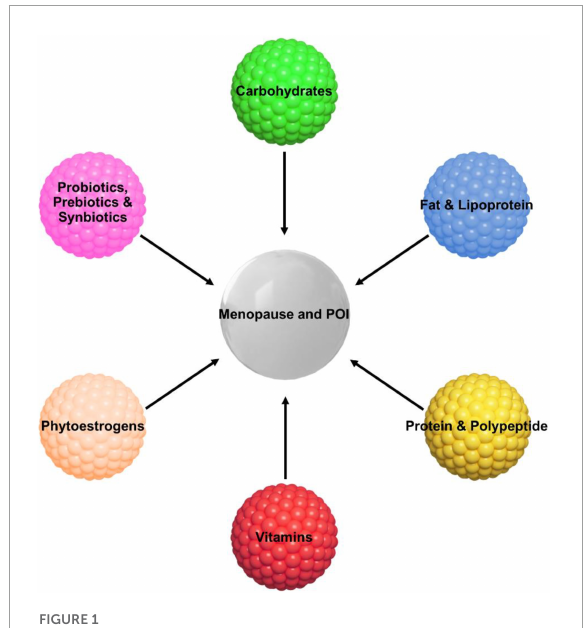
FIGURE1 Primary nutritional factors for progression, alleviation and control of menopause and